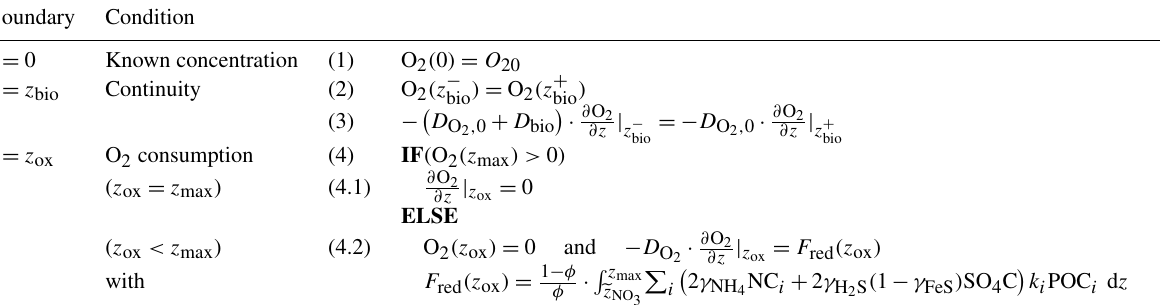
= lim h → − h) and z + = lim h → + h) . 0 (z bio 0 (z bio bio bio